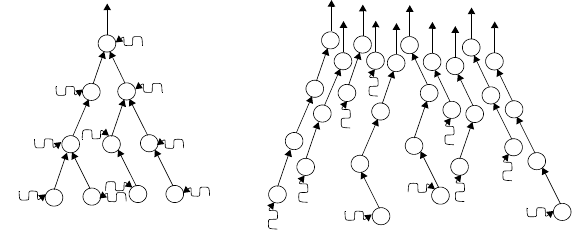
Figure 9. Sink tree network with flow aggregation (left) converted to a set of flow-local views by Theorem 7